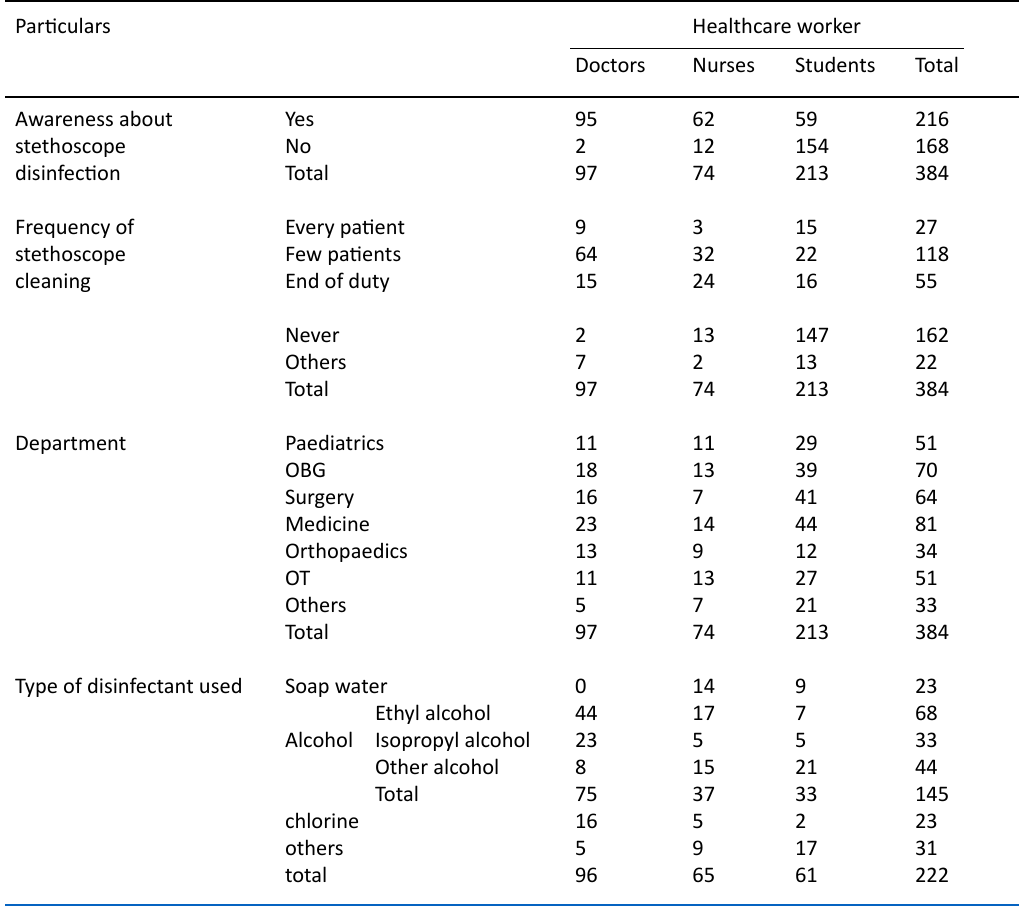
Table 2. Major data obtained from questionnaire